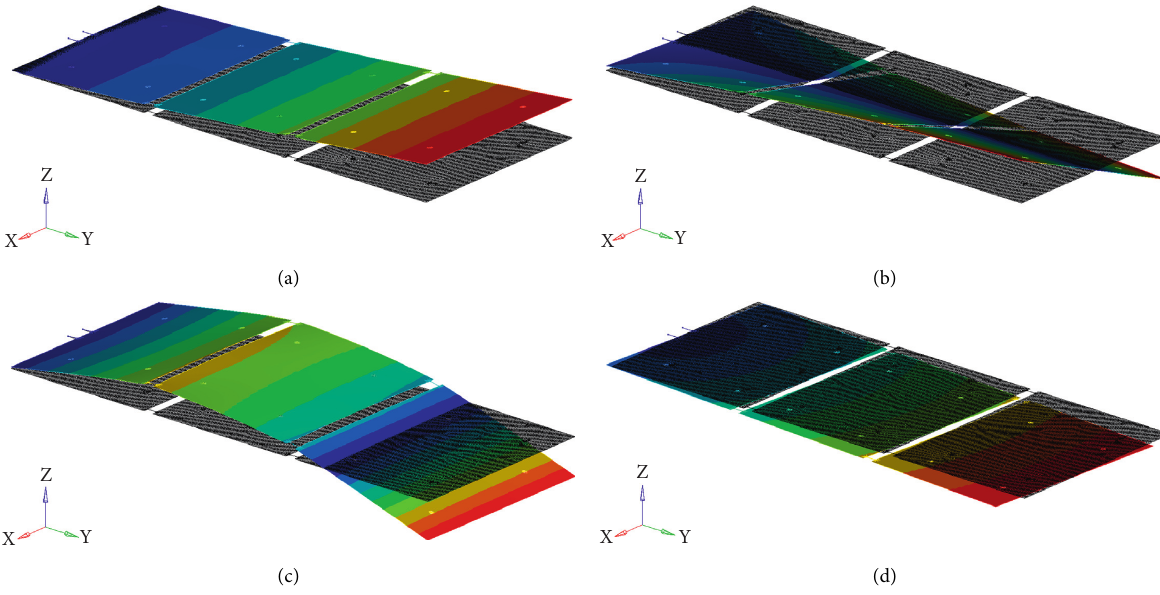
Figure 9: First four-order modes of the threefold solar array of honeycomb sandwich plates: (a) mode 1: freq. � 0.9.556Hz; (b) mode 2: freq. � 2.6.972Hz; (c) mode 3: freq. � 5.5.747Hz; (d) mode 4: freq. � 5.8.707Hz. Table 4: Natural frequencies of the threefold solar array in the horizontal direction.